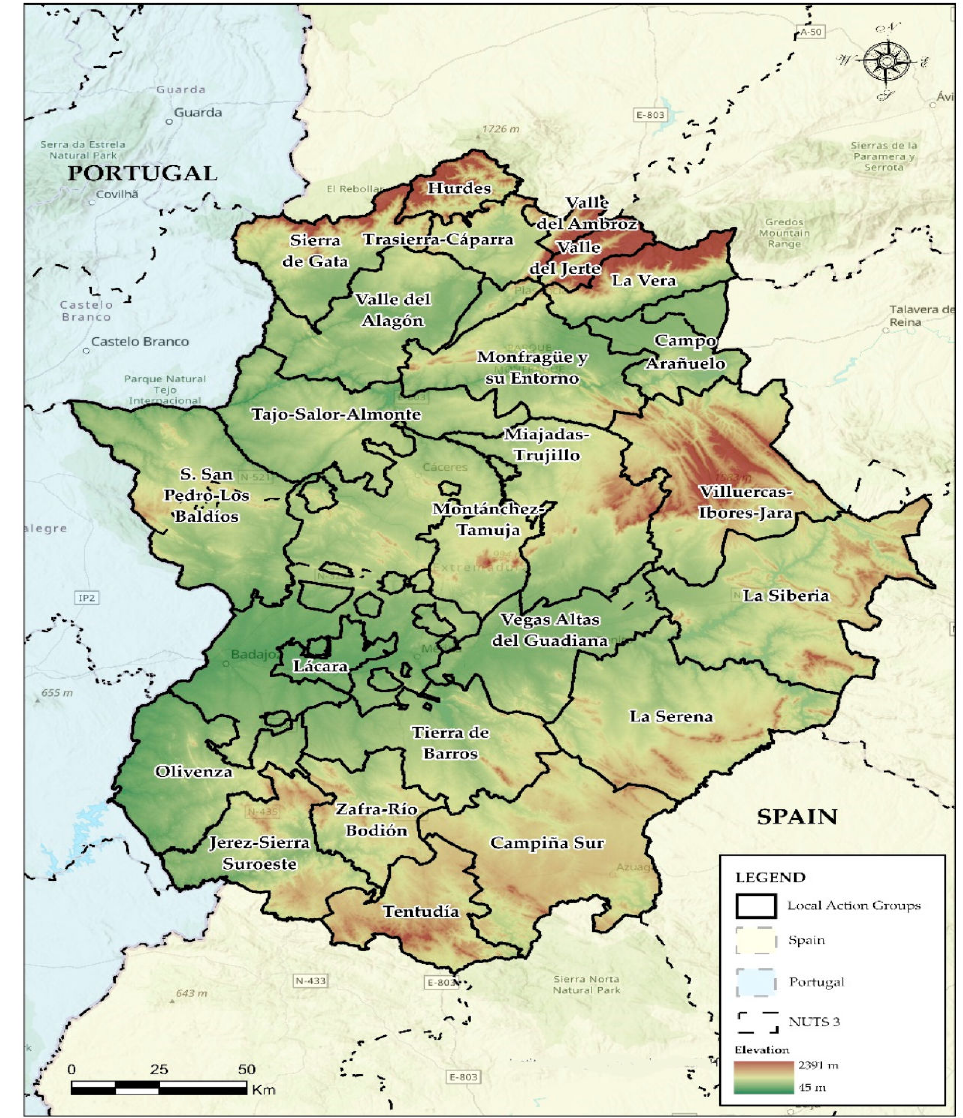
Figure 2. Study area: Extremadura (Spain) and the territorial scope of the LAGs. Source: